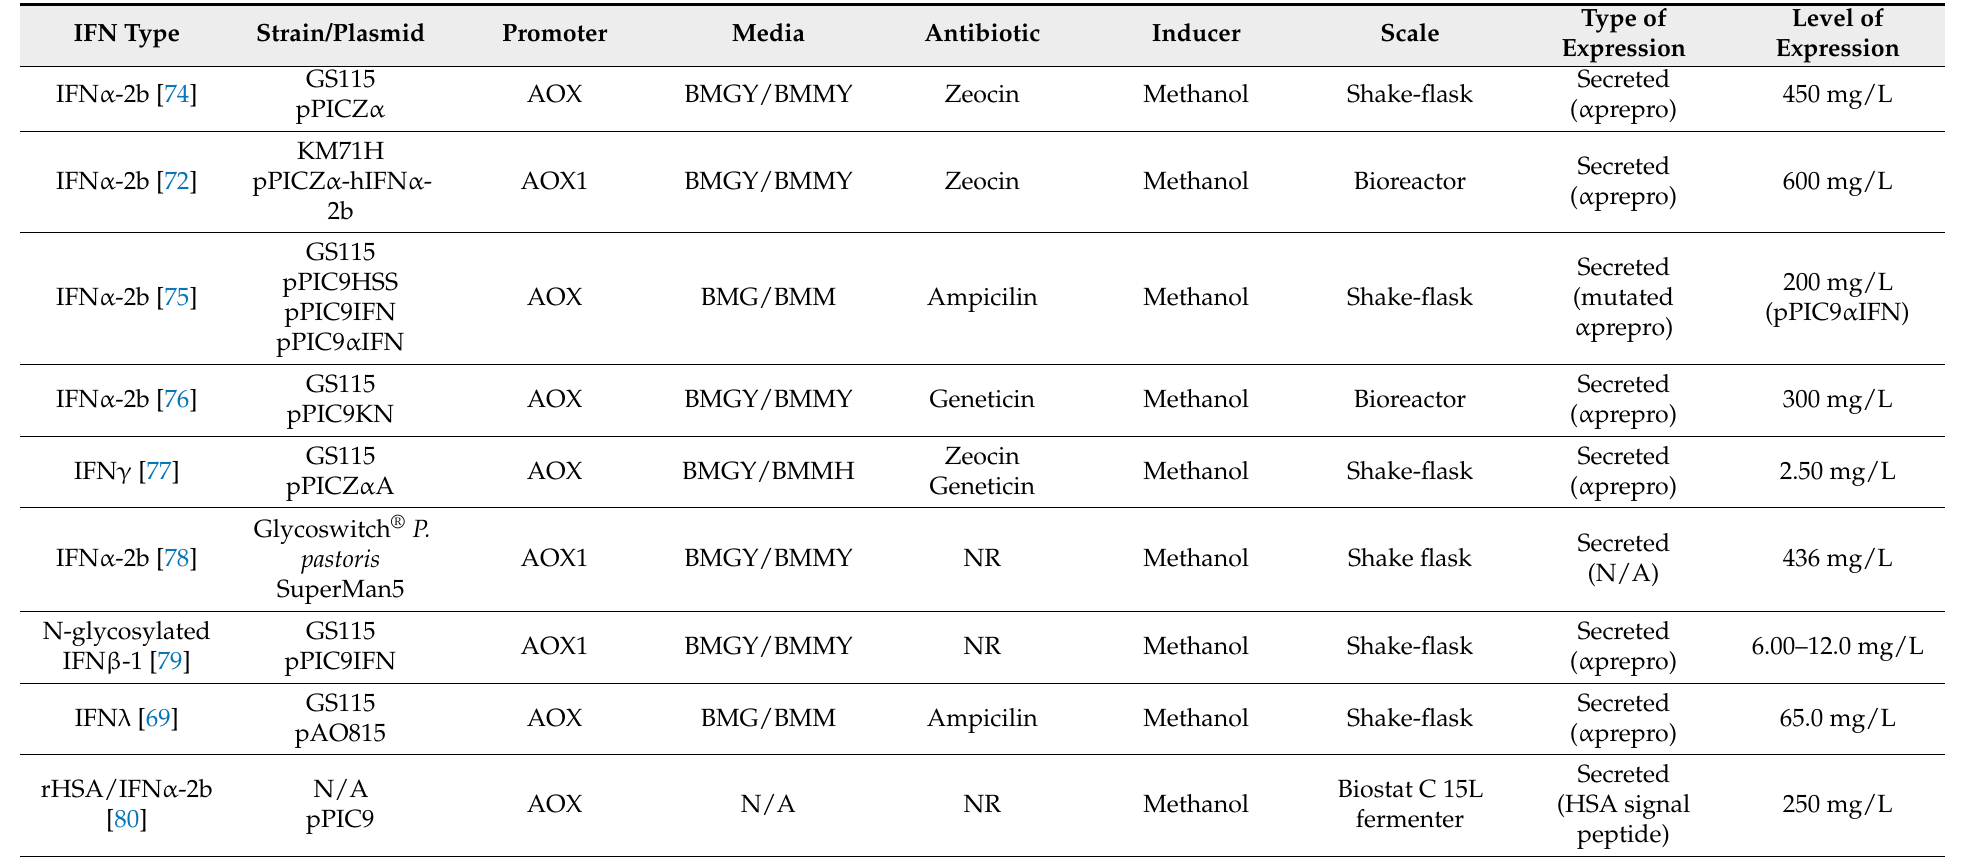
Table 4. Representative studies of the expression of therapeutic IFNs in Pichia pastoris recombinant